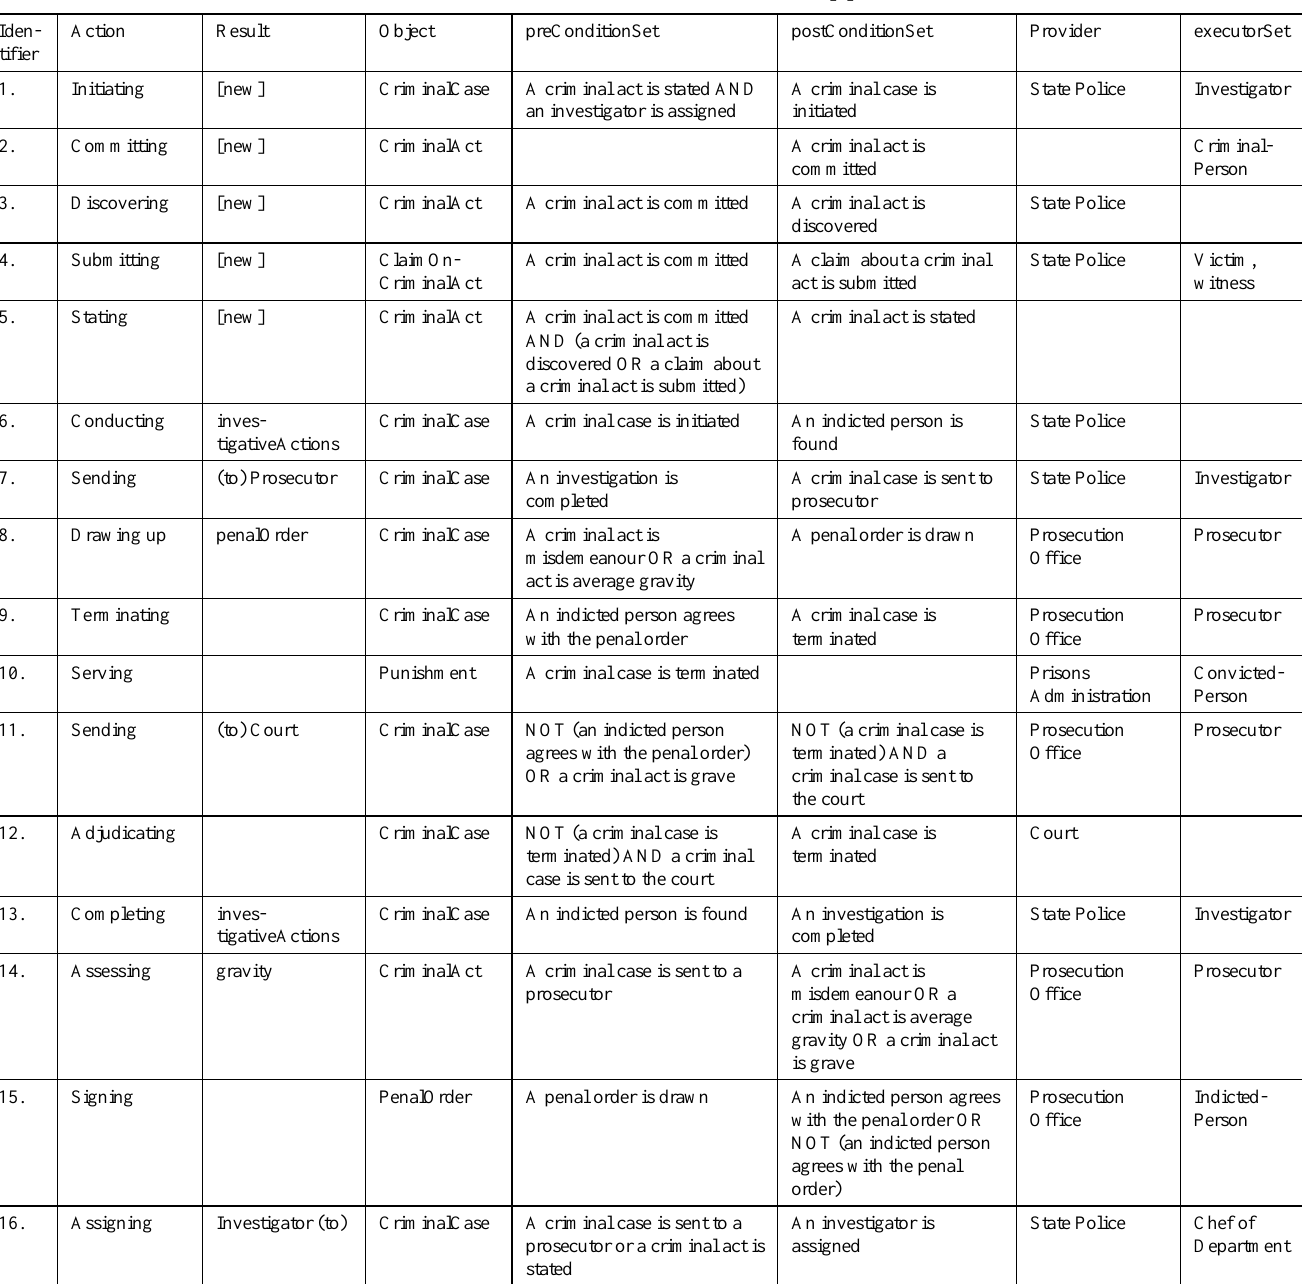
F RAME I NSTANCES FOR F UNCTIONAL F EATURES